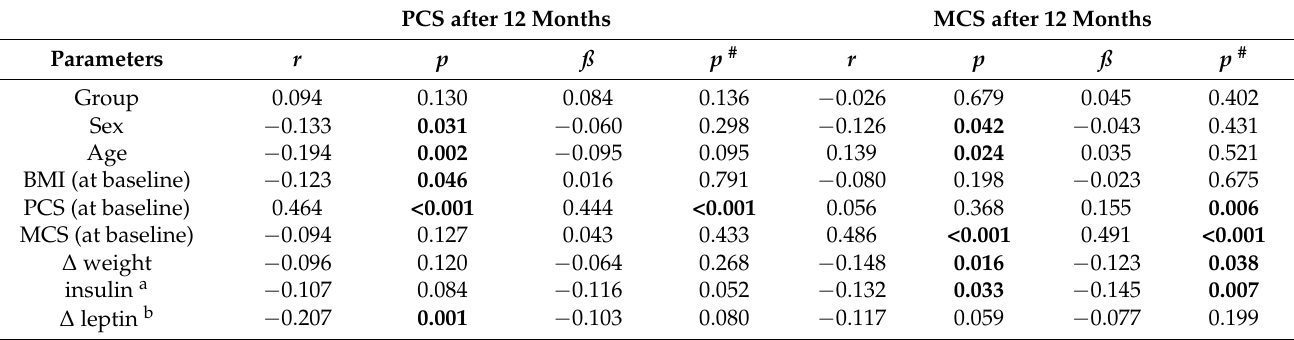
Table 3. Predictive parameters for improvement in PCS or MCS after 12 months.